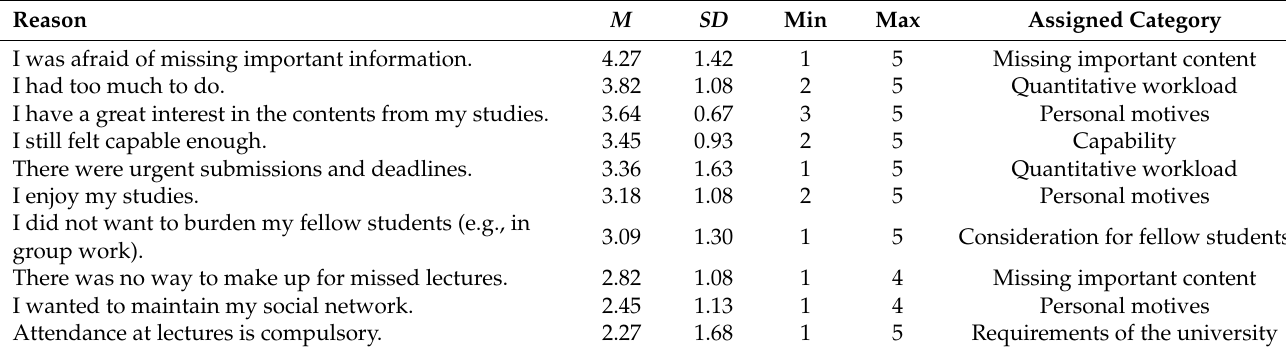
Table A1. Results of the scaling questions on the reasons for